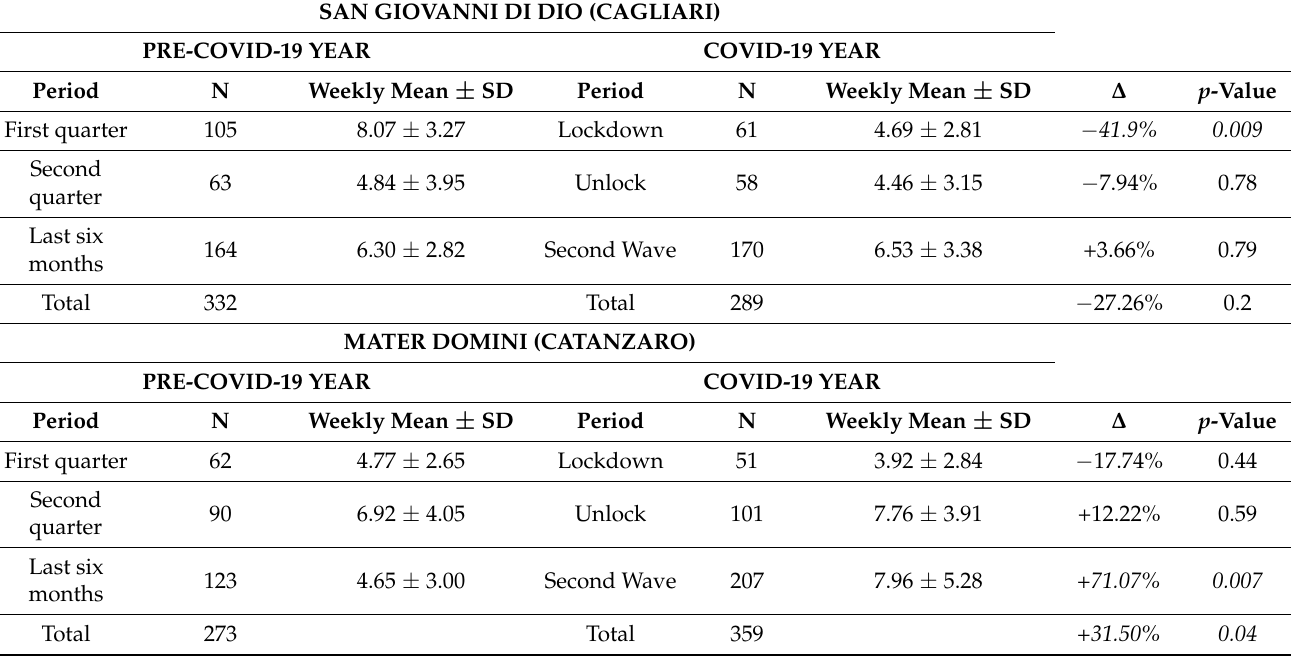
Table 4. Number of vitreoretinal surgical procedures performed at San Giovanni di Dio (SGD), University of Cagliari, and Mater Domini, University Magna Græcia of Catanzaro (UMG), divided by periods of lockdown, unlock, and second wave, respectively.